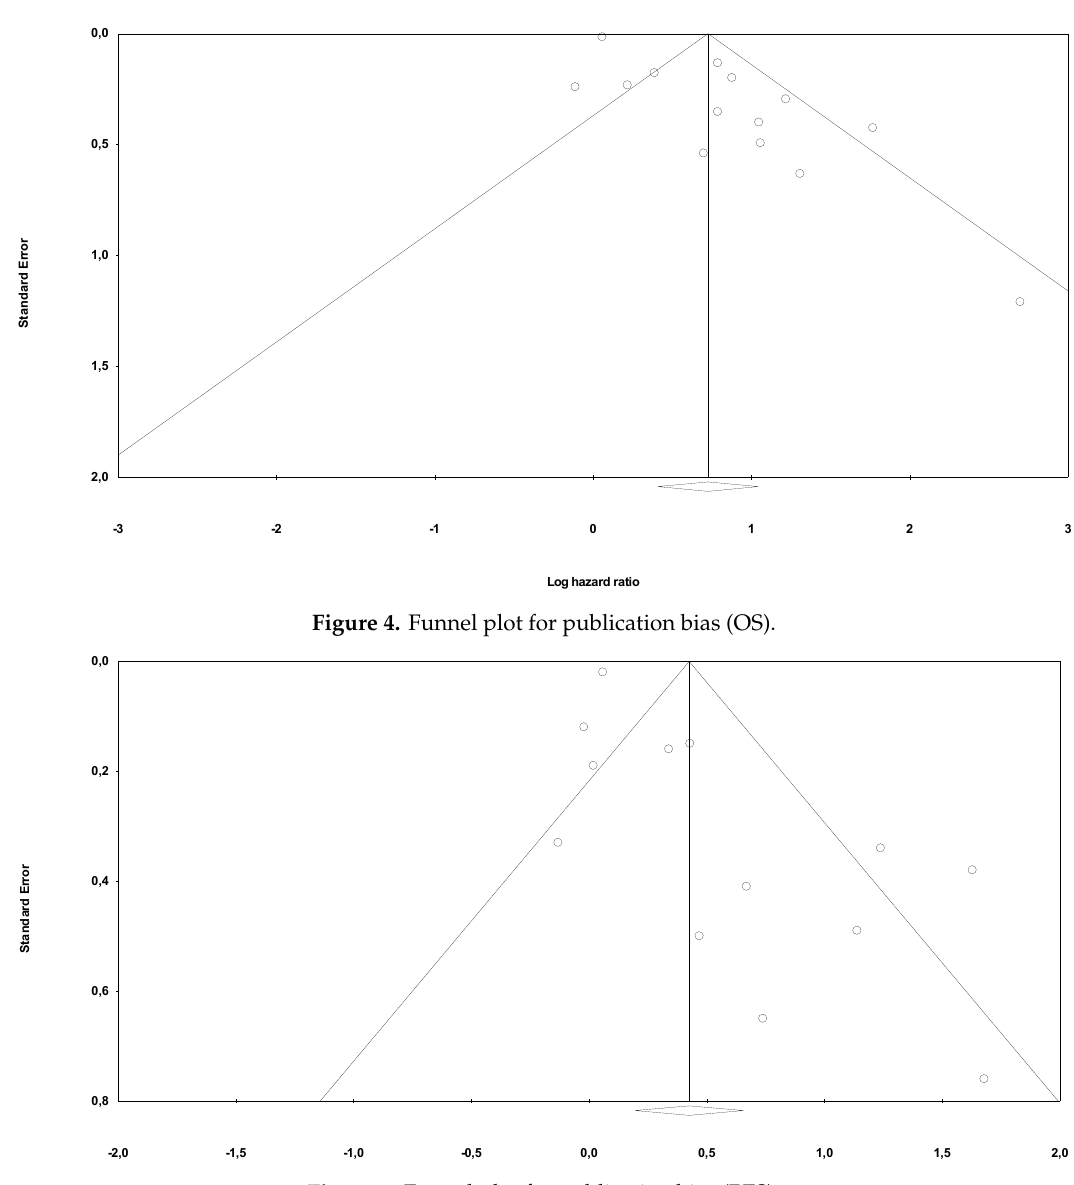
Figure 5. Funnel plot for publication bias (PFS) .